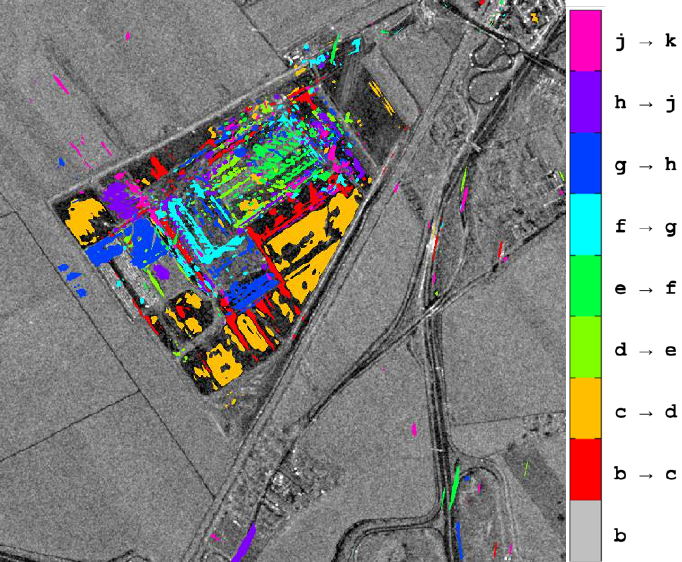
Figure 25. New objects colored according to their time of installation for the factory hall constructed near Ludwigshafen (Germany)—Curvelet-based